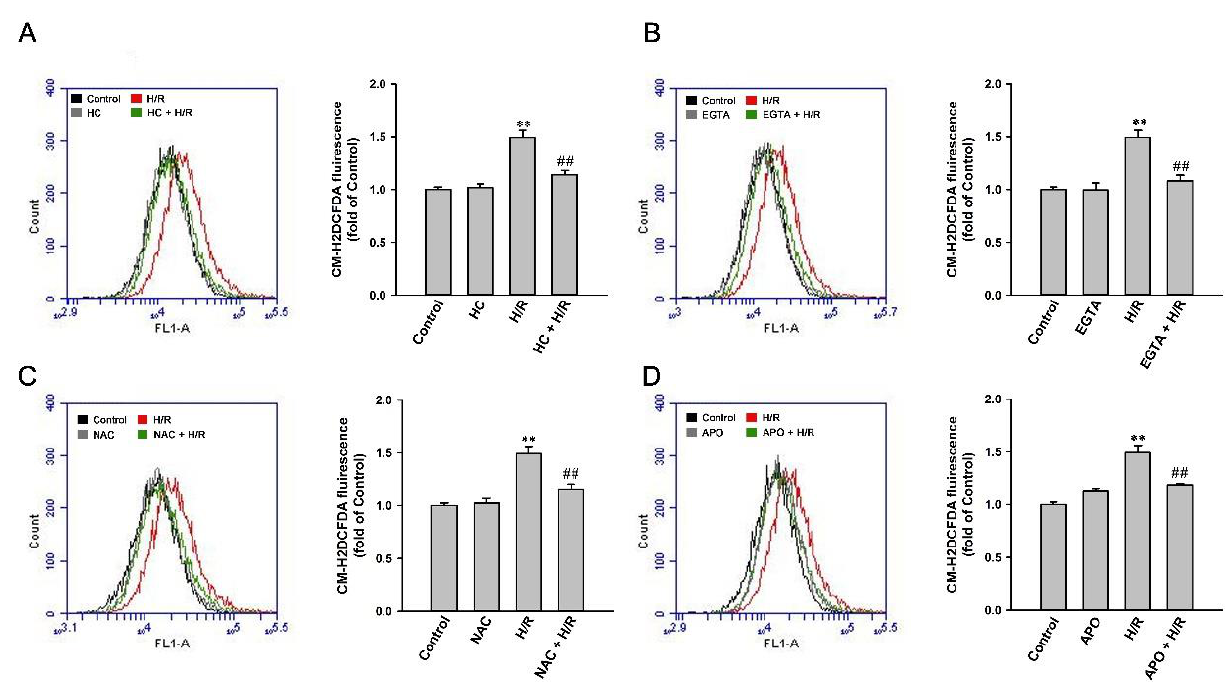
Figure 8. H/R-induced intracellular ROS increase via a ROS-dependent, TRPA1-mediated, and NOX-released pathway in HK-2 cells. ( A ) HK-2 cells were incubated under normoxia conditions (control) or exposed to 2.5% O 2 for 6 h, followed by 4 h of reoxygenation. In two study groups, cells were pretreated with HC-030031 (HC, a TRPA1 antagonist; 9 µ M). ( B ) HK-2 cells were incubated under normoxia conditions (control) or exposed to 2.5% O 2 for 6 h, followed by 4 h of reoxygenation. In the two study groups, cells were pretreated with EGTA (an extracellular Ca 2+ chelator; 500 µ M). ( C ) HK-2 cells were incubated under normoxia conditions (control) or exposed to 2.5% O 2 for 6 h, followed by 4 h of reoxygenation. In two study groups, cells were pretreated with N-acetyl-cysteine (NAC, a scavenger of ROS; 1 mM). ( D ) HK-2 cells were incubated under normoxia conditions (control) or exposed to 2.5% O 2 for 6 h, followed by 4 h of reoxygenation. In two study groups, cells were pretreated with apocynin (APO; an inhibitor of NADPH oxidase; 150 µ M). Intracellular ROS levels were measured by flow cytometry, and CM-H2DCFDA (general oxidative stress indicator) was used for the assay. Data in each group are the mean ± SEM from five independent experiments. ** p < 0.01 versus the control group or time zero; ## p < 0.01 versus the H/R group without drug pretreatment.